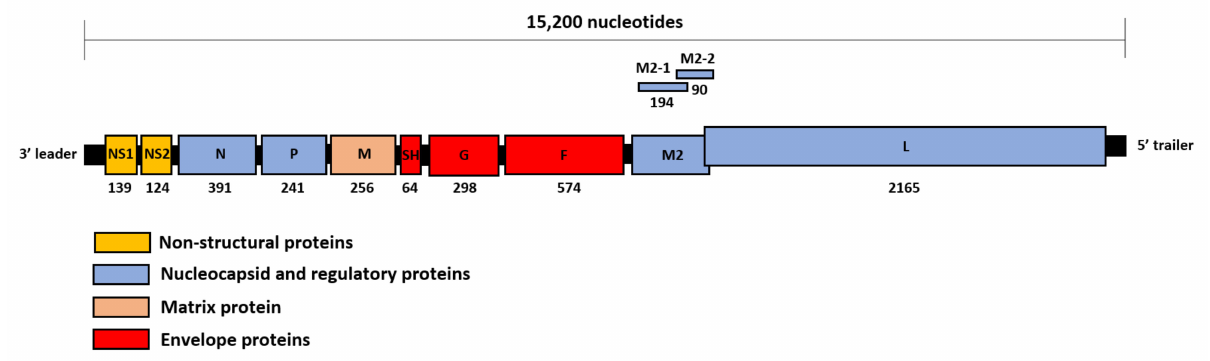
Figure 1. Schematic diagram of the RSV genome organization. The approximate length of the RSV genome is indicated on top of the figure. The number of amino acid residues of the viral proteins is shown below each open reading frame as present on the antisense RSV